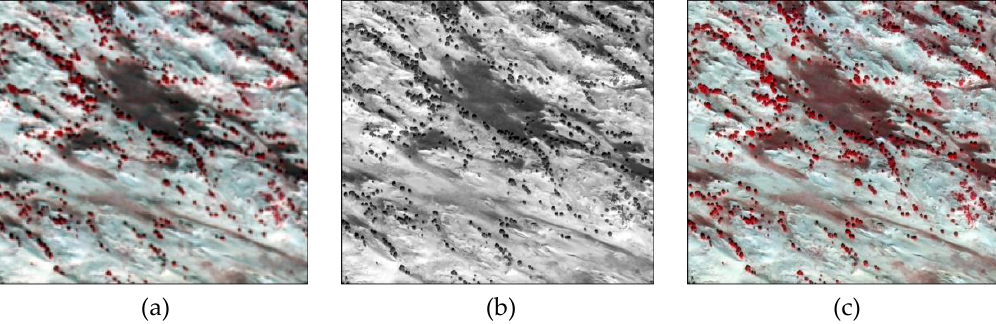
Figure 2. Comparison of GF-2 panchromatic, multispectral, and fused images (partial). (a) Original multispectral image (composed with red, greed, and blue bands), (b) original panchromatic image, and (c) nearest-neighbor diffusion fused image (composed with red, greed, and blue bands).